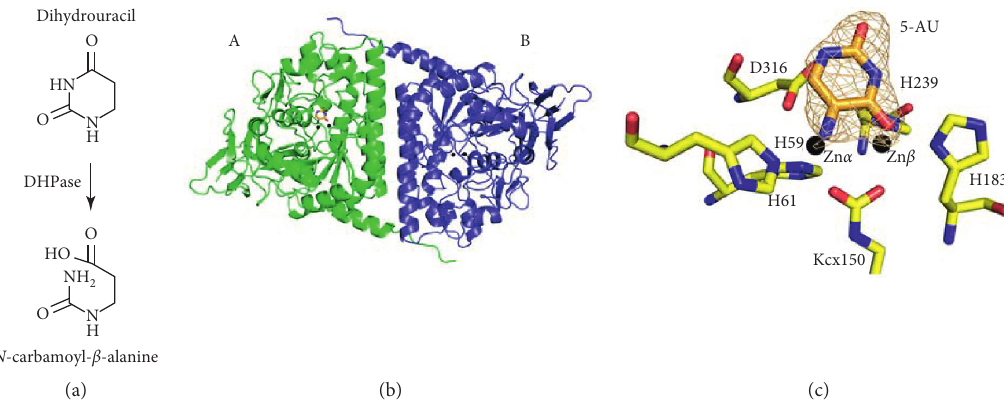
Figure 1: The structure of PaDHPase complexed with 5-AU. (a) The physiological reaction of DHPase. (b) The complexed structure of PaDHPase with 5-AU. The monomers are colored differently. 5-AU was found only in monomer A and not in monomer B. (c) The active site of PaDHPase. The binuclear metal center assembled by residues His59, His61, carbamylated Lys150 (Kcx150), His183, His239, and Asp316 in PaDHPase is essential for catalytic activity. The light orange mesh is the 2Fo-Fc electron density map from the 5-AU contoured at 1 σ with a 1.6 ˚A carve radius. Both two zinc ions were involved in binding